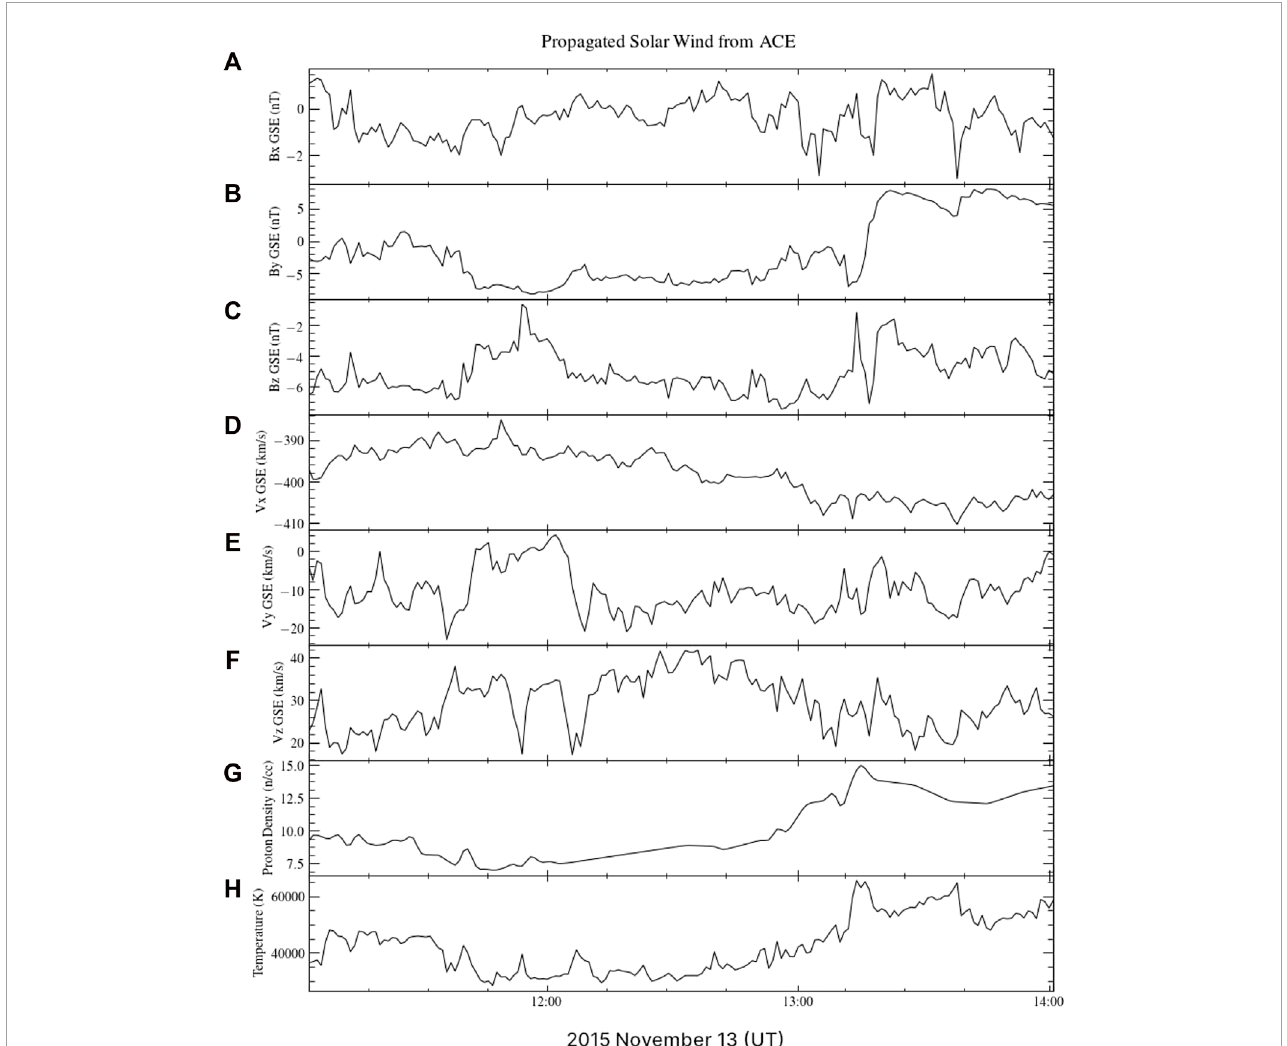
FIGURE 1 Combined ACE and THEMIS C data, propagated forward 62 min to the nominal bow shock. All data shown here are from ACE except the proton densities, which are from THEMIS C and have been time-shifted to correspond with the ACE data. The period of interest is from about 11:45 UT to shortly before 13:00. (A–C) show the X, Y, and Z components in GSE coordinates of the IMF. (D–F) show the X, Y, and Z components in GSE coordinates of the solar wind bulk velocity. (G) shows the solar wind proton density and (H) shows the solar wind ion temperature. (Data provided at https://cdaweb.gsfc.nasa.gov/).